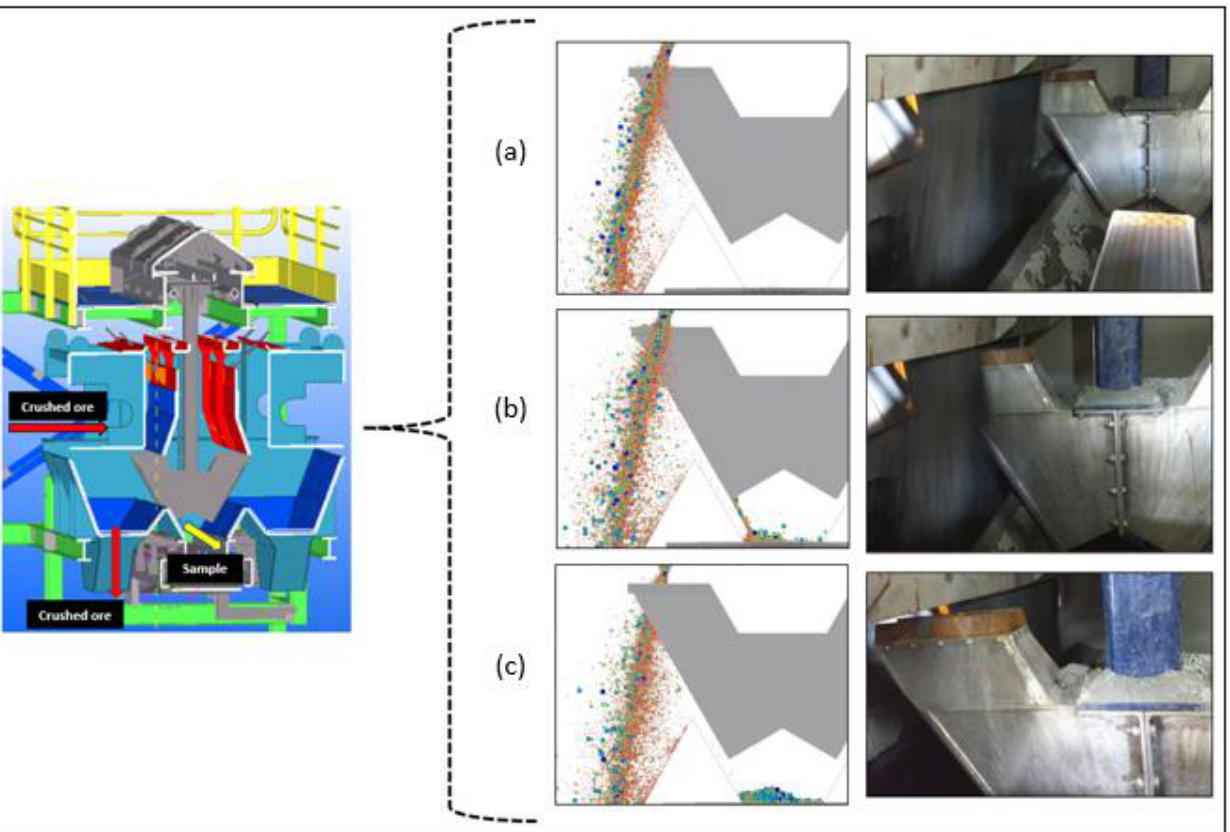
Figure 3. 3-D geometry of the of the cross-stream cutter installed plant feed stream ( left ). Side view of the cutter as implemented in Rocky and real pictures of the cutter ( right ): ( a ) beginning ( b ) middle ( c ) end of cut.